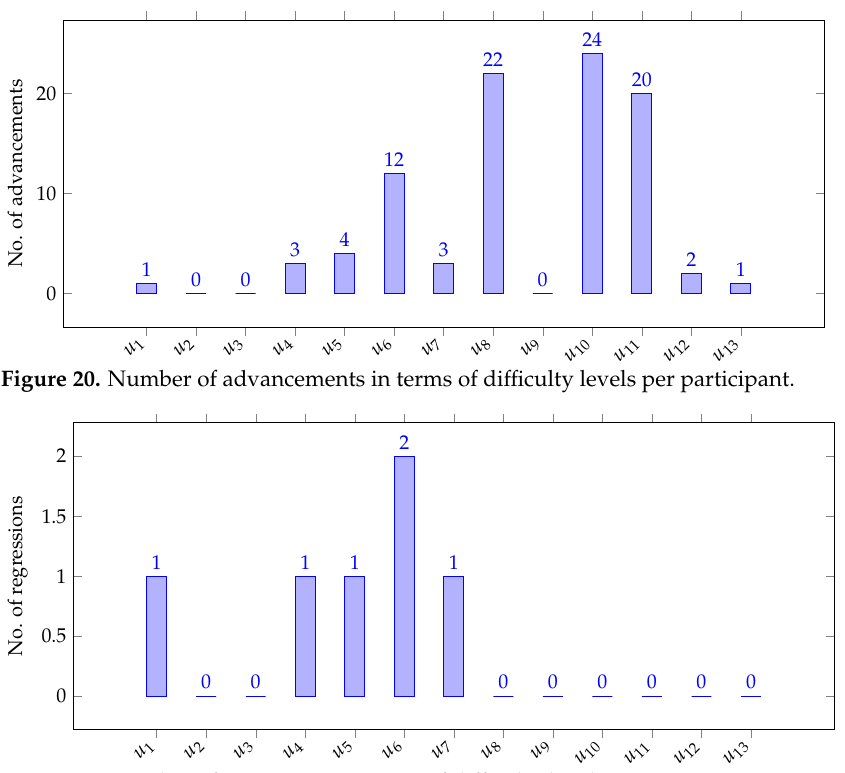
Figure 21. Number of regressions in terms of difficulty levels per